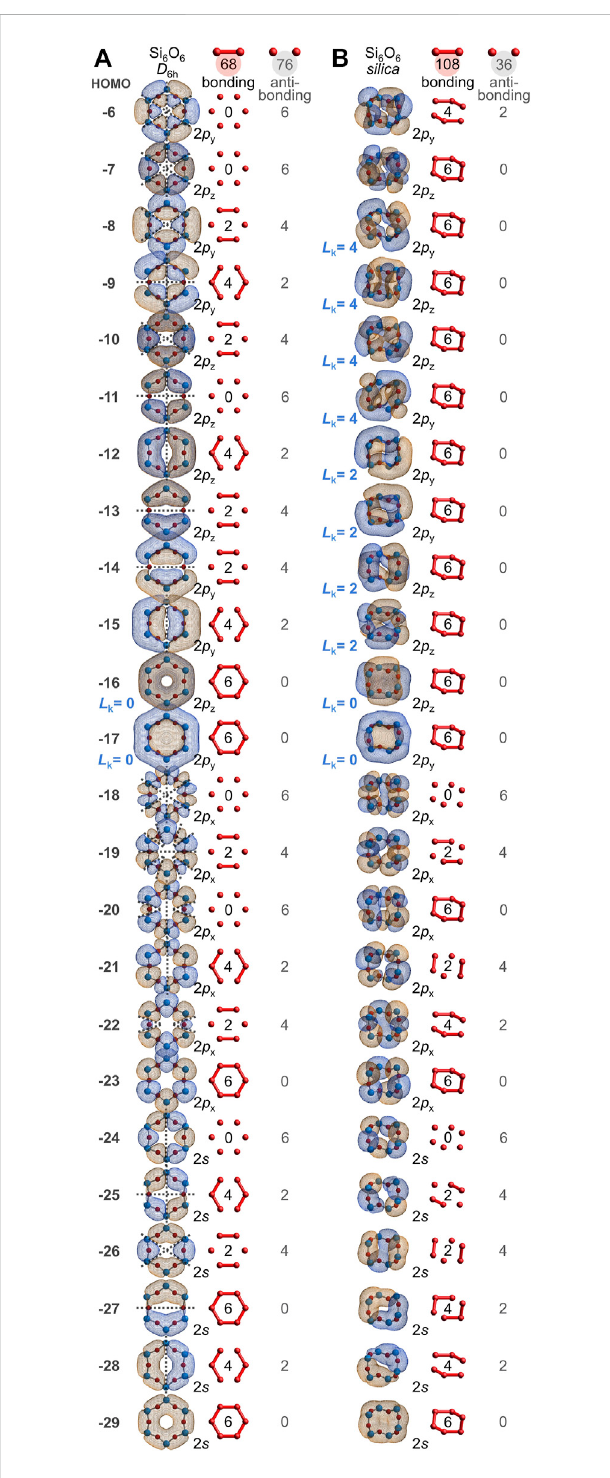
FIGURE 5 Oxygen-based valence molecular orbitals (IsoValue = 0.005 [e/ bohr 3 ] 0.5 ) for geometry-optimized, planar D 6h Si 6 O 6 (A) and for chiral, saddle-shaped Si 6 O 6 found in quartz silica (B) . Bonding and anti- bonding O-O interactions are tabulated and contiguous π molecular orbitals are classi fi ed as either Hückel aromatic ( L k = 0) or Möbius aromatic ( L k = 2 or